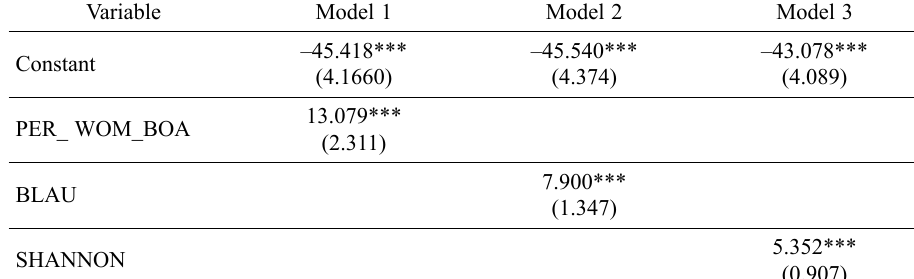
Table 2. System GMM Estimation of the influence of female directors on the logarithm transformation of fraction of variable based pay Variable Model 1 Model